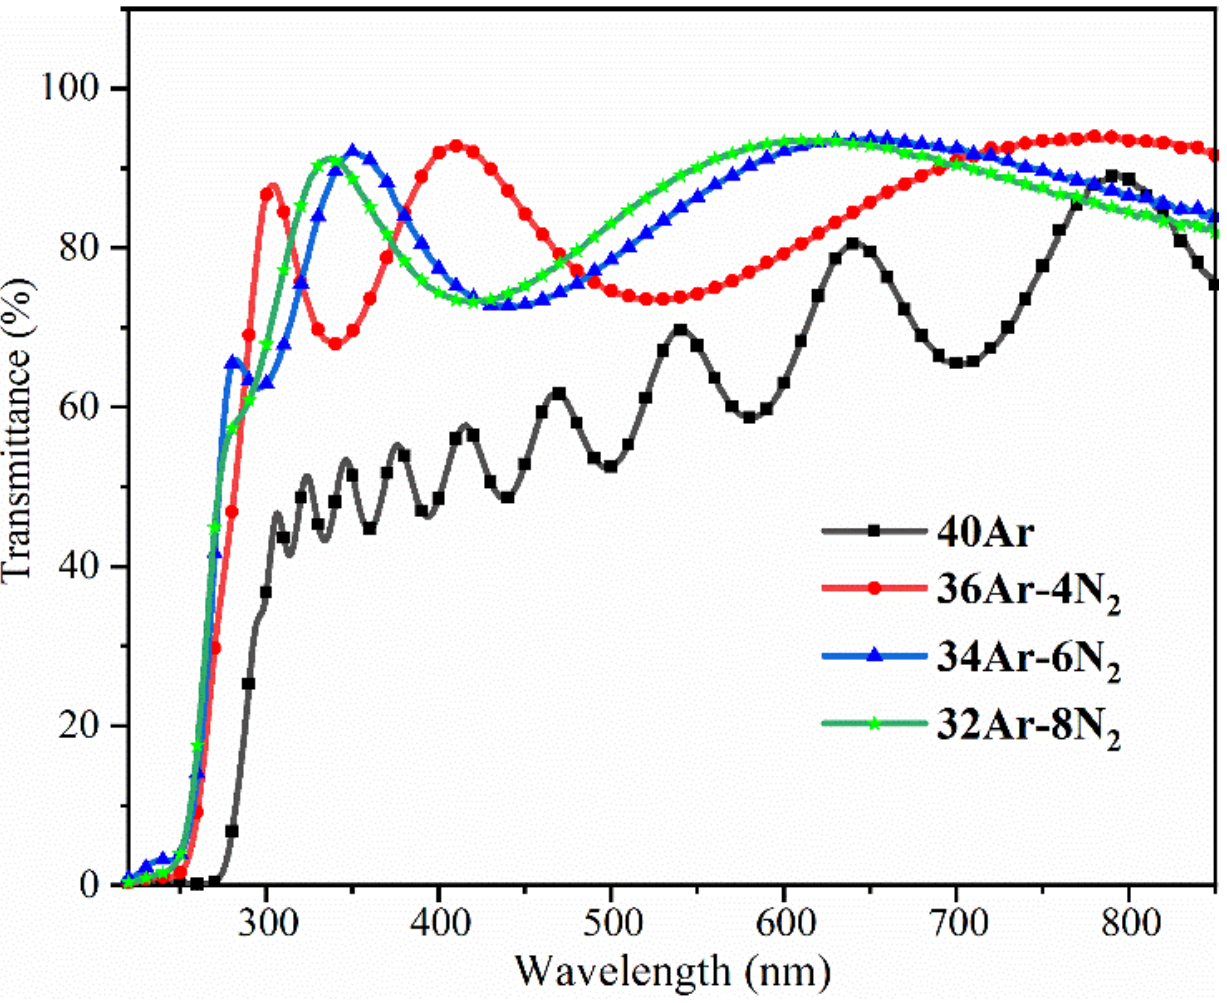
Figure 6. The transmittance of Ta 2 O 5 coatings deposited at a sputtering power of 140 W under different N 2 and Ar flow rates.